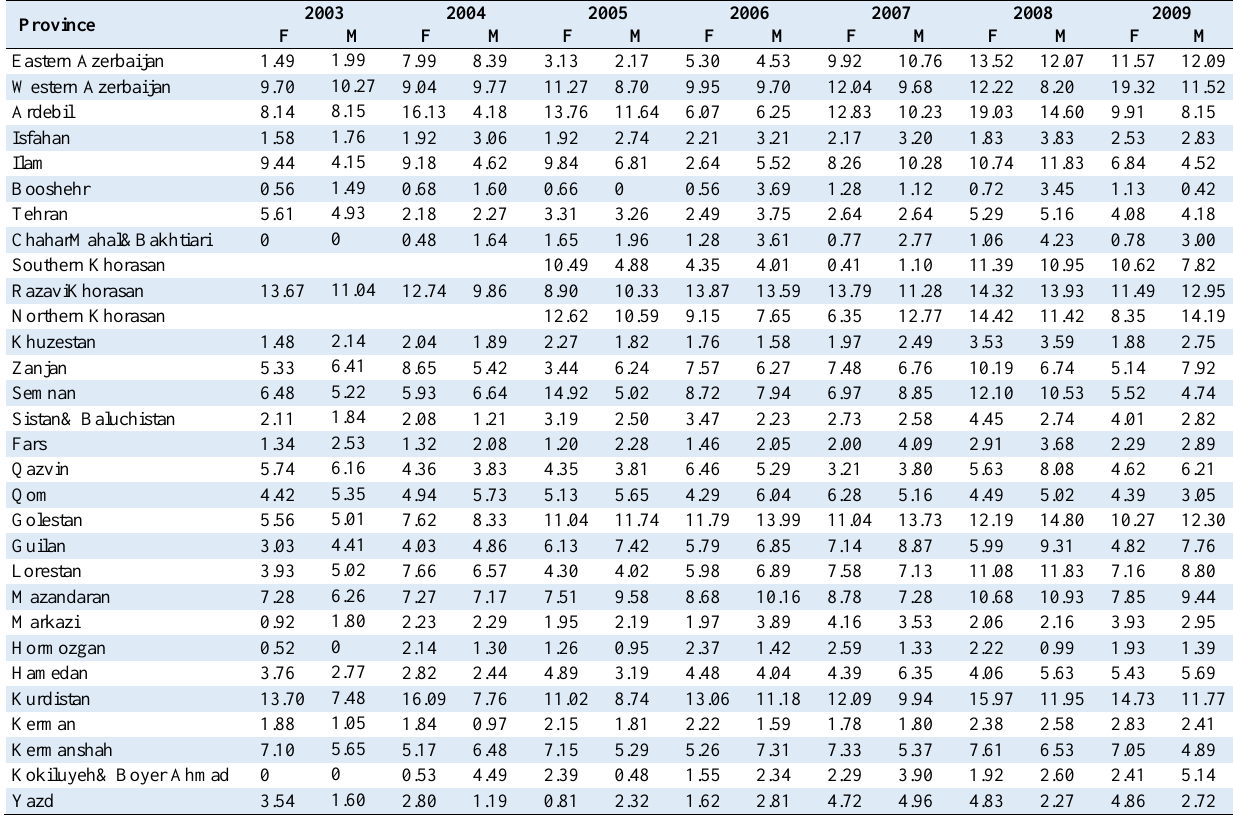
Table 2. Standardized Mortality Rate of esophageal cancer in national provinces during years 2003-2009